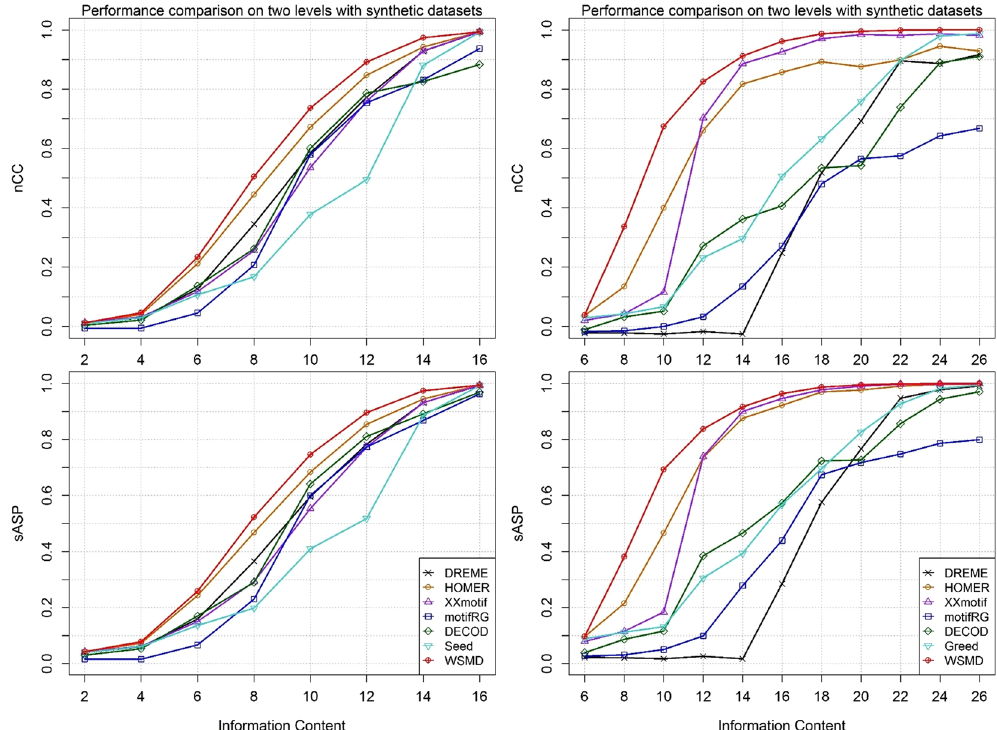
Figure 3. Performance comparison of different refinement and extension strategies. For each IC value, we show the average performance obtained by using each tools over 10 distinct synthetic datasets. ( a ) Performance comparison of different refinement strategies. ( b ) Performance comparison of different extension